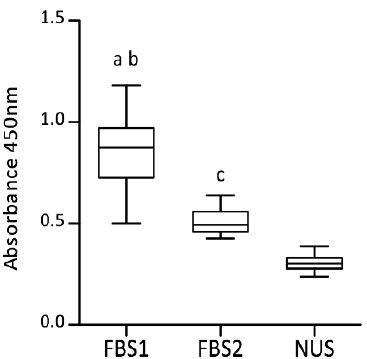
Figure 2. Counts of viable monocyte-derived macrophages. Data obtained using Cell Counting Kit-8 are expressed as absorbance (450 nm) values. Boxplots represent data from the MDM culture with fetal bovine serum (FBS1 and FBS2) or with reduced-serum medium (NUS): median (line), first and third quartiles (box), and minimum and maximum (whiskers), n = 18. Significant differences (Friedman test with Dunn’s multiple-comparison post hoc test) between groups are marked as follows: a FBS1 vs. FBS2, p < 0.05; b FBS1 vs. NUS, p < 0.05; c FBS2 vs. NUS, p < 0.05.